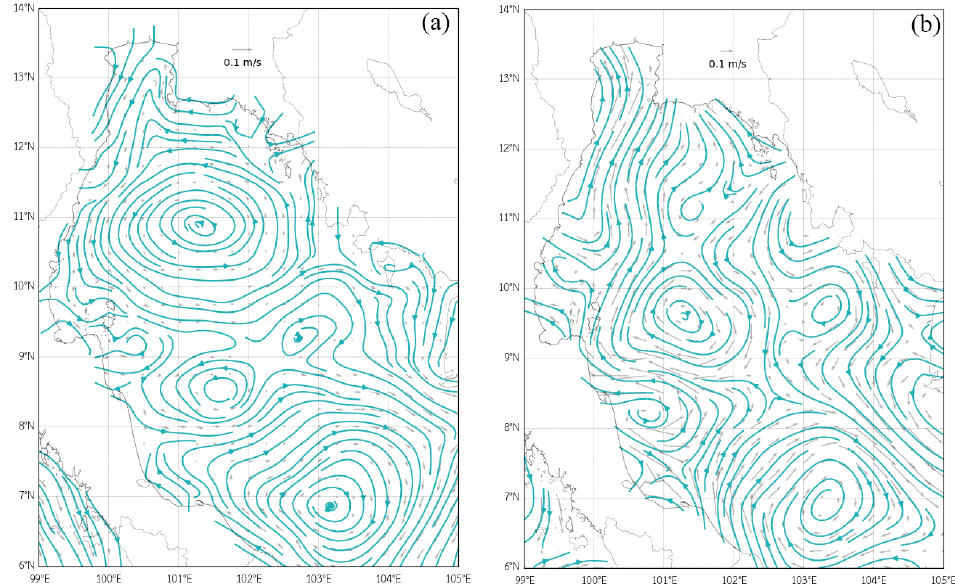
Figure 9. The simulated ( a ) mean surface current velocity from OCM and ( b ) mean surface current from OSCAR in October